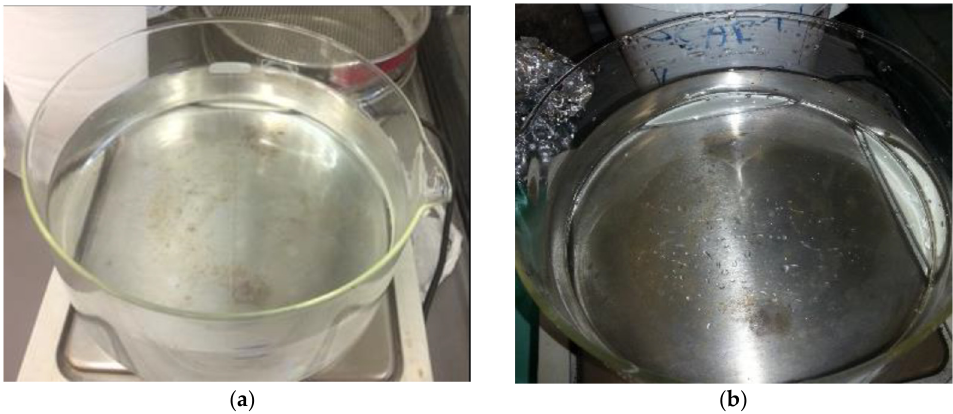
Figure 9. Water appearance after test n.3 with a thin film of diesel using ( a ) Grafysorber ® G+; ( b ) PP. Therefore, the substantial difference between the two materials lies in the ability to retain diesel, with a value of over 76 g/g for G+ at the 1st cycle compared to about 13 g/g for